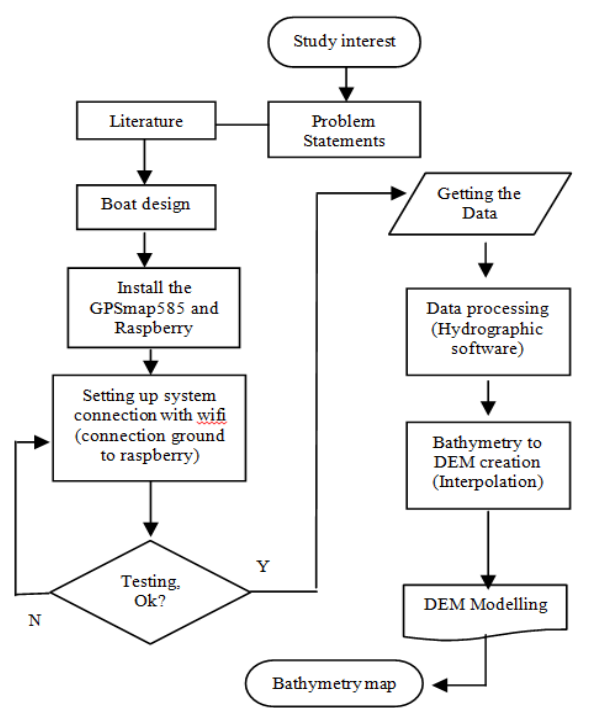
Figure 7. General workflow process for system setup (e.g. using GPSmap585) and processing.